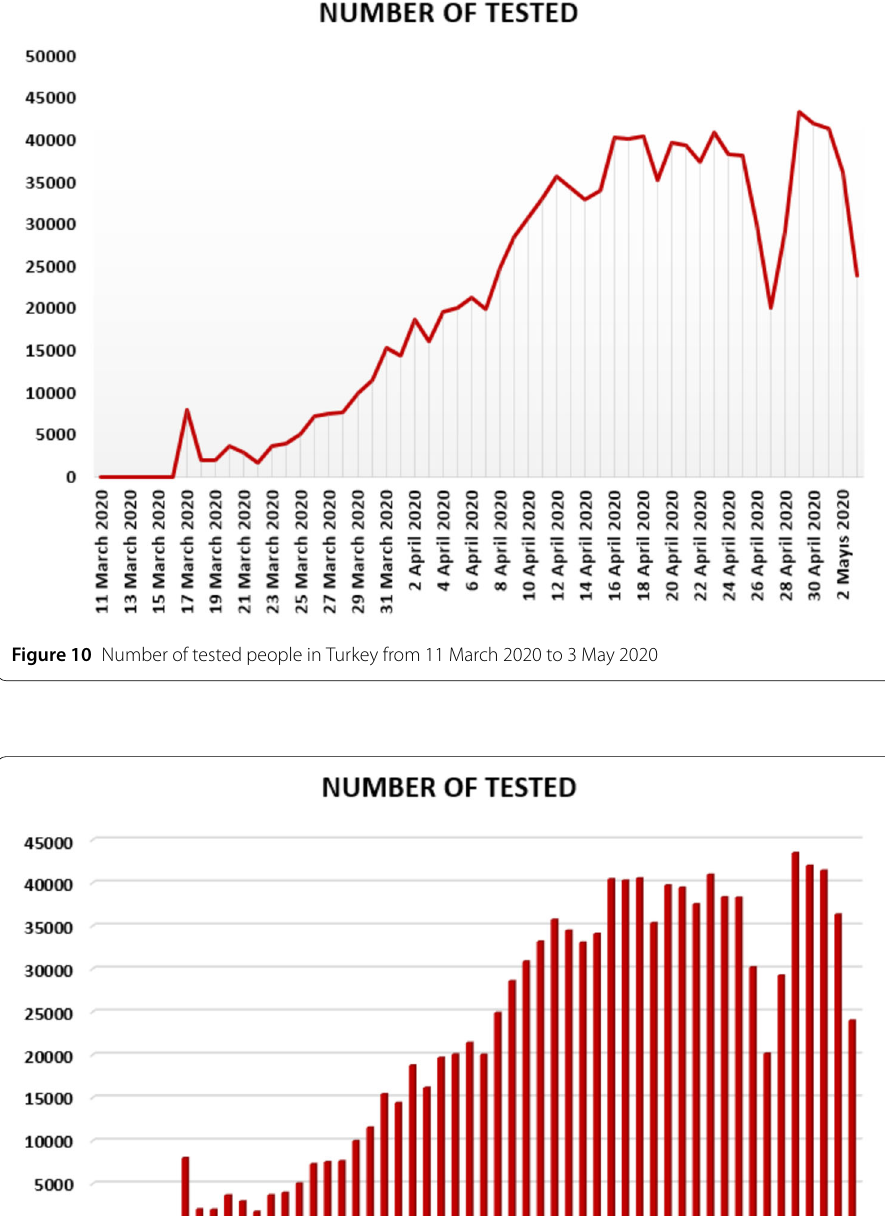
means that the significance of fit for the model is unsuitable to predict outcomes. In other words, the obtained model is not suitable for the given data and it should be discarded in favor of another model that should be